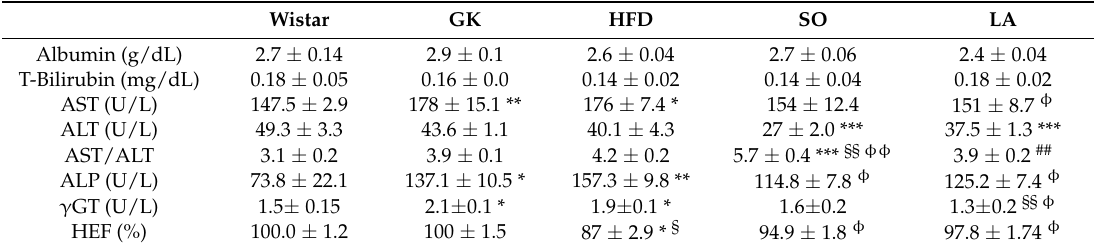
Table 2. Serum levels of albumin, total bilirubin, alanine aminotransferase, aspartate aminotransferase, alkaline phosphatase, gamma-glutamyltranspeptidase, and hepatic extraction fraction of Wistar and Goto-Kakizaki rats and in GK rats fed with a high fat diet with or without α -lipoic acid and soybean oil. Wistar GK HFD SO LA Albumin (g/dL) 2.7 ± 0.14 2.9 ± 0.1 2.6 ± 0.04 2.7 ± 0.06 2.4 ± 0.04 T-Bilirubin (mg/dL) 0.18 ± 0.05 0.16 ± 0.0 0.14 ± 0.02 0.14 ± 0.04 0.18 ± 0.02 AST (U/L) 147.5 ± 2.9 178 ± 15.1 ** 176 ± 7.4 * 154 ± 12.4 151 ± 8.7 φ ALT (U/L) 49.3 ± 3.3 43.6 ± 1.1 40.1 ± 4.3 37.5 ± 1.3 *** AST/ALT 3.1 ± 0.2 3.9 ± 0.1 4.2 ± 0.2 5.7 ± 0.4 *** §§ φφ 3.9 ± 0.2 ## ALP (U/L) 73.8 ± 22.1 137.1 ± 10.5 * 157.3 ± 9.8 ** 114.8 ± 7.8 φ 125.2 ± 7.4 φ γ GT (U/L) 1.5 ± 0.15 2.1 ± 0.1 * 1.9 ± 0.1 * HEF (%) 100.0 ±